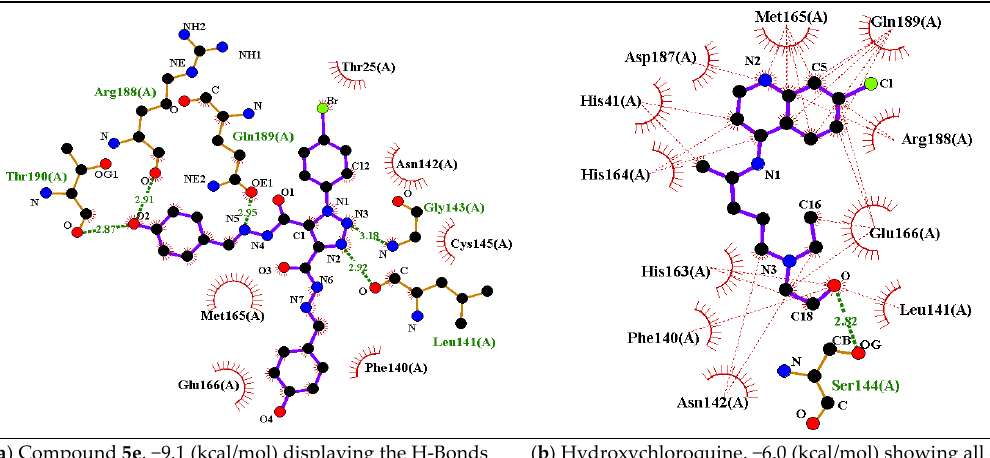
( a ) Compound 5e , −9.1 (kcal/mol) displaying the H-Bonds ( b ) Hydroxychloroquine, −6.0 (kcal/mol) showing all of Figure 8. A schematic of 2D LIGPLOT drawings of 5e and hydroxychloroquine against 7BQY protease using the 2D LIGPLOT representation of the protein–ligand interactions [44]; ( a ) a diagram showing the hydrogen bonds and hydrophobic residues of 5e with 7BQY; ( b ) a diagram showing the hydrogen bonds and hydrophobic residue interactions of hydroxychloroquine with 7BQY protease. A key to the symbols is reported before [45]. The cutoff for the nonbonded interactions is 3.9 Å.